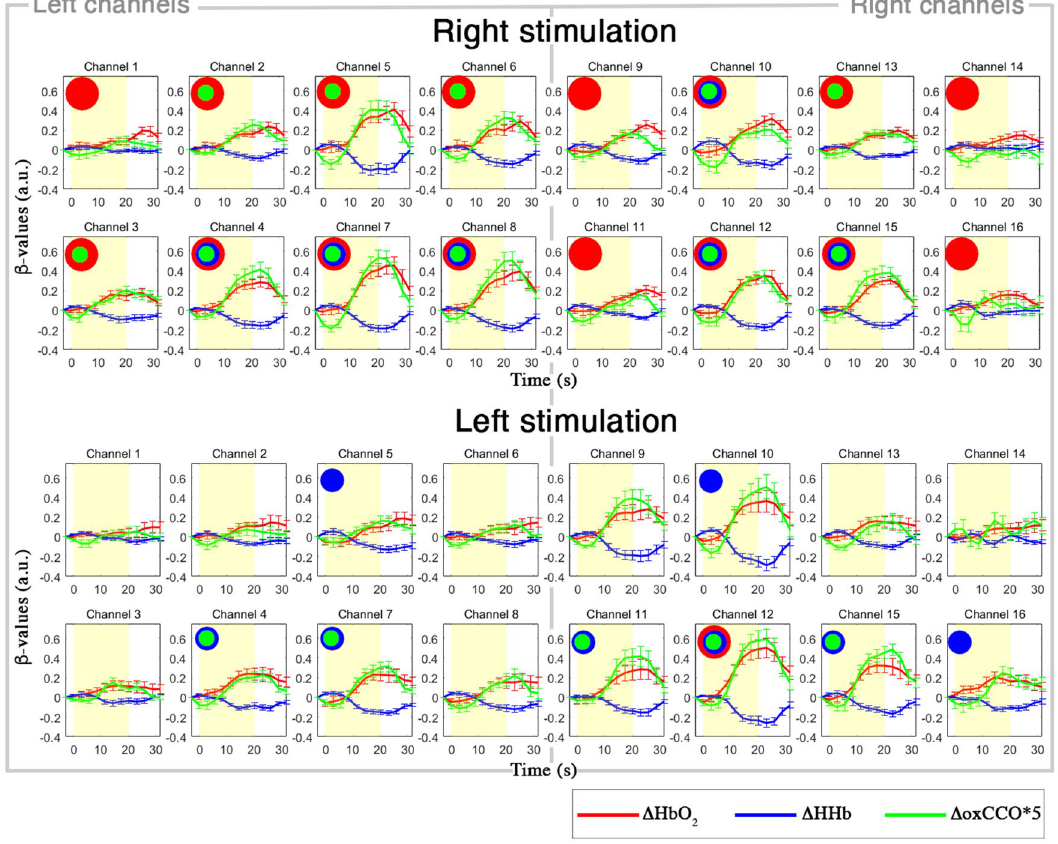
Figure 3. Grand-averaged responses (mean ± std. error) for the Right (top) and Left (bottom) visual hemifield condition, for each channel. Single-subject responses are estimated through the FIR-GLM and averaged across the group. The yellow area indicates the task block. ΔHbO 2 is shown in red, ΔHHb in blue, ΔoxCCO (magnified by a factor of 5 for better visualization) in green. Red circles represent statistically significant ΔHbO 2 changes, blue circles statistically significant ΔHHb changes, and green circles statistically significant ΔoxCCO changes (p < 0.005, FDR corrected for multiple